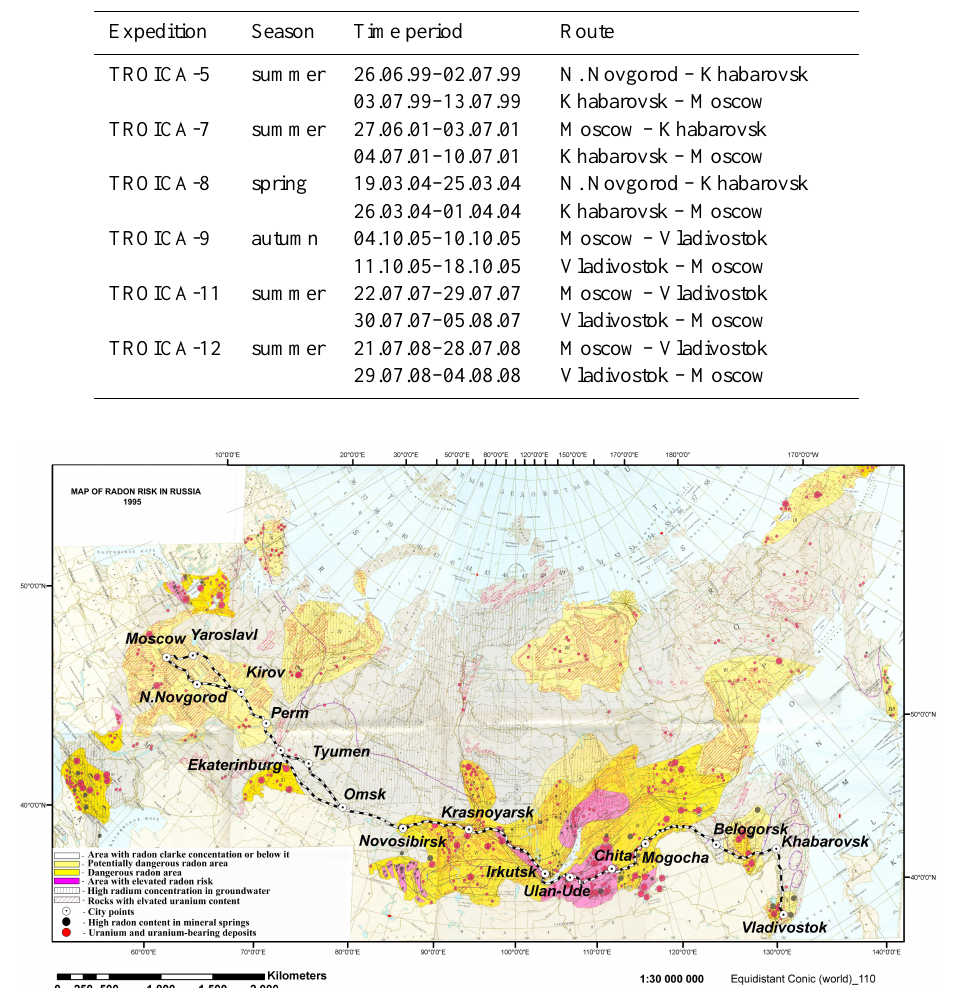
for 20 different initial sets of the radon daughters